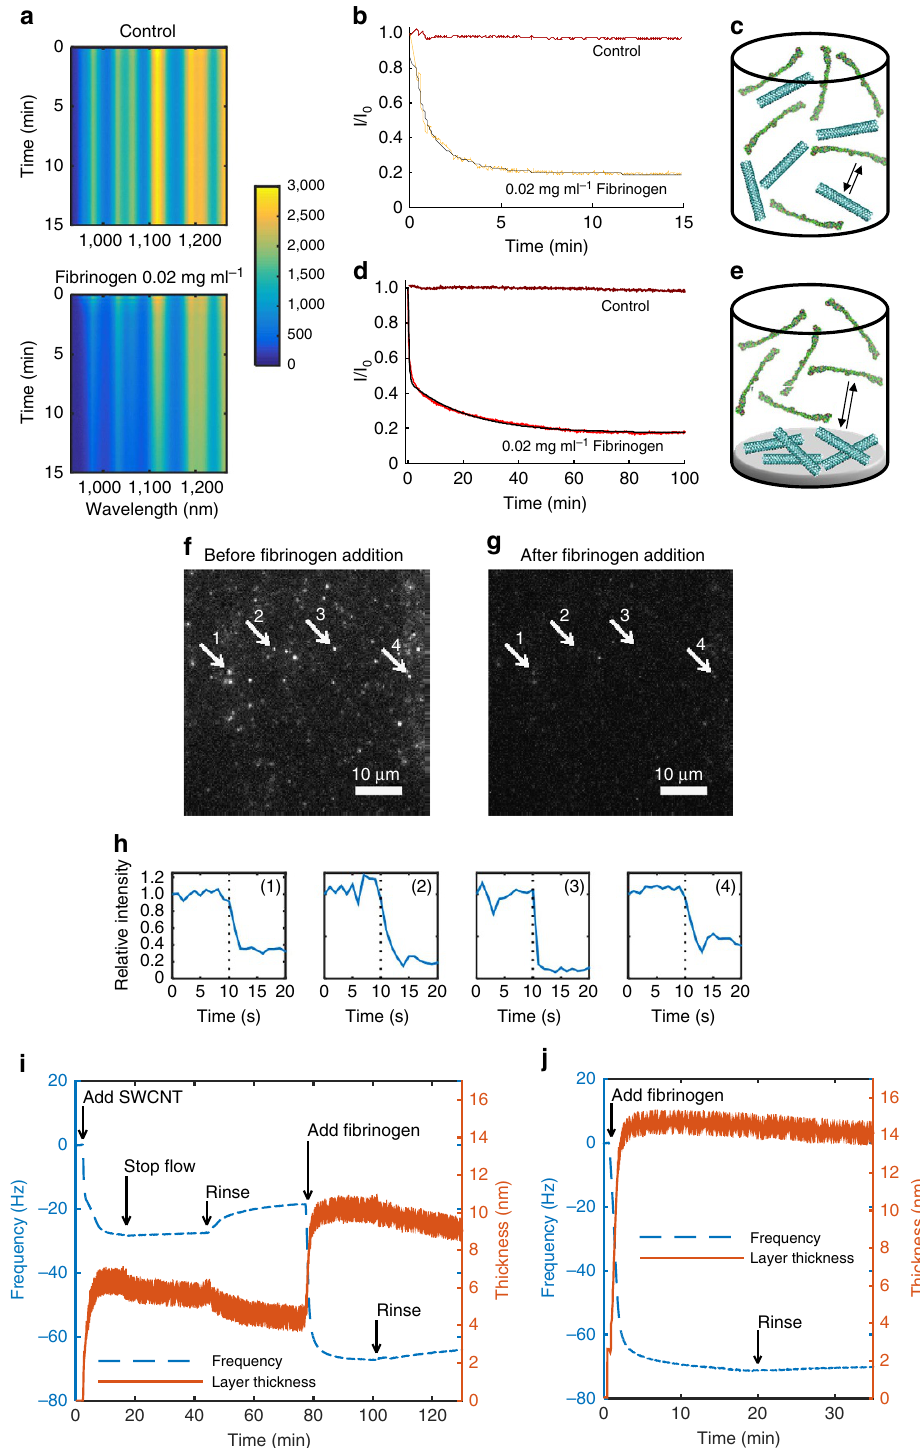
Figure 4 | Dynamics of the SWCNT–fibrinogen interaction. ( a ) Fluorescent emission spectra of 1mgl (cid:2) 1 DPPE-PEG(5000)-SWCNT, to which either PBS (top) or 0.02mgml (cid:2) 1 fibrinogen (bottom) was added 10s after the beginning of the experiment. Since laser excitation was turned off while adding the solutions, the time point of the PBS or fibrinogen addition appears as a horizontal line with zero intensity. ( b ) The (10,2) chirality fluorescent emission peak over time of 1mgl (cid:2) 1 DPPE-PEG(5000)-SWCNT, to which either PBS (control) or 0.02mgml (cid:2) 1 fibrinogen was added. Data taken from a . ( c ) Illustration of solution phase experiment. ( d ) Fluorescent emission over time of immobilized DPPE-PEG(5000)-SWCNT in agarose hydrogel, to which either PBS (control) or 0.02mgml (cid:2) 1 fibrinogen was added. ( e ) Illustration of hydrogel phase experiment. ( f ) Single DPPE-PEG(5000)-SWCNT fluorescence recorded by a 2D nIR camera before and ( g ) after the addition of fibrinogen. ( h ) Corresponding intensity time traces of the four diffraction limited single SWCNT spots marked in panels f and g . The dotted line represent the time point at which fibrinogen was added. ( i ) Frequency change (dashed blue curve) and layer thickness (solid orange curve) as measured by QCM-D, and calculated by the Voigt viscoelastic model, respectively, for a fibrinogen layer deposited on top of a DPPE-PEG(5000)-SWCNT layer, and for ( j ) fibrinogen layer deposited directly on top of the gold-coated quartz